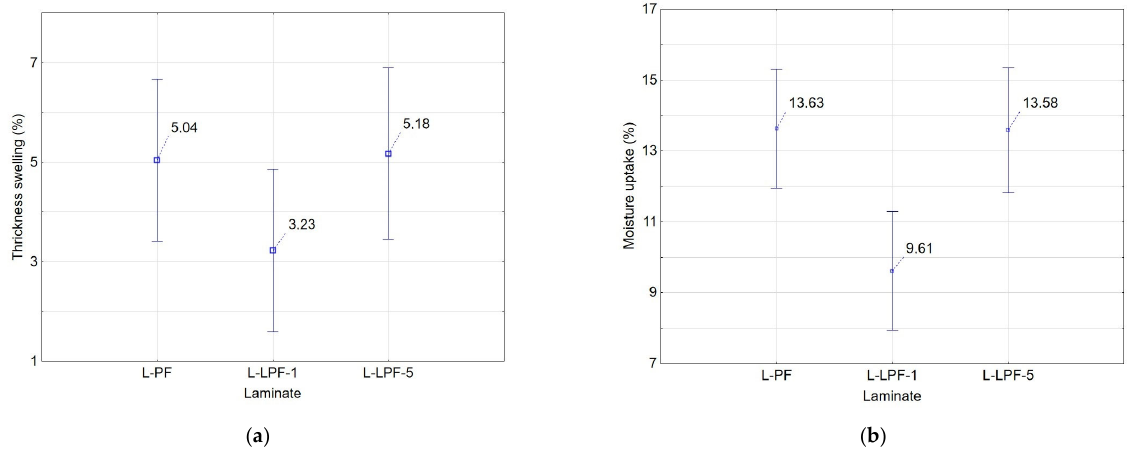
Figure 4. Influence of resin on ( a ) thickness swelling, ( b ) moisture uptake.